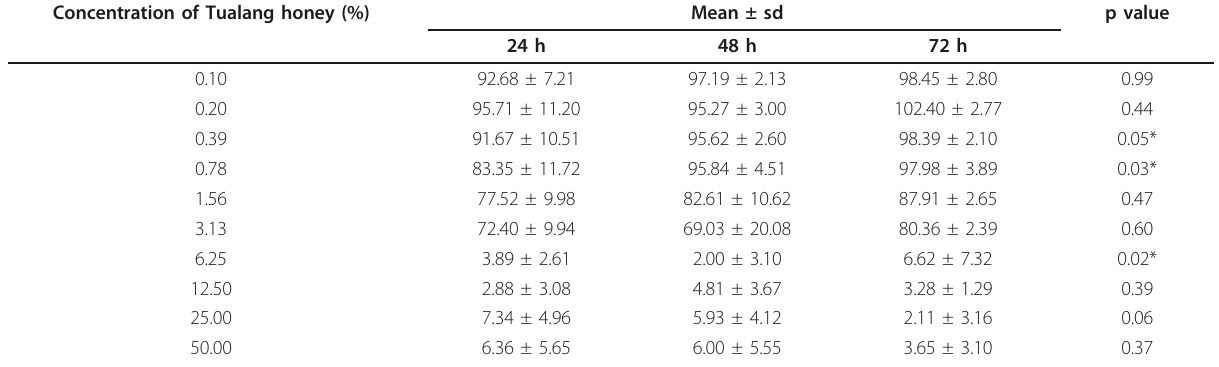
Table 1 Cell proliferation in pKHDF after being treated with Tualang honey methanolic extracts at three different time of exposure Concentration of Tualang honey (%)